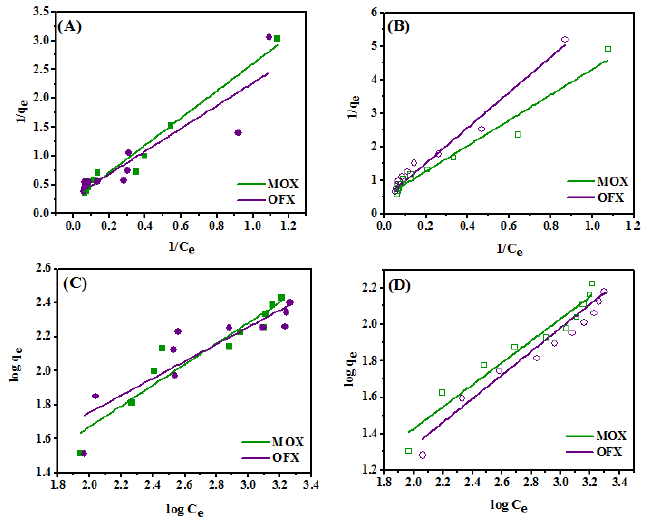
Figure 11. Langmuir models for the adsorption of MOX and OFX onto Met-GO/SA ( A ) and GO/SA ( B ). Freundlich isotherm models for the adsorption of MOX and OFX onto Met-GO/SA ( C ) and GO/SA ( D ). Adsorption conditions for Met-GO/SA as adsorbent (time: 140 min; temperature: 35 °C, adsorbent dosage: 0.25 g, pH: 7) and GO/SA as adsorbent (time: 200 min; temperature: 35 °C; adsorbent dosage: 0.4 g, pH: 7), respectively.